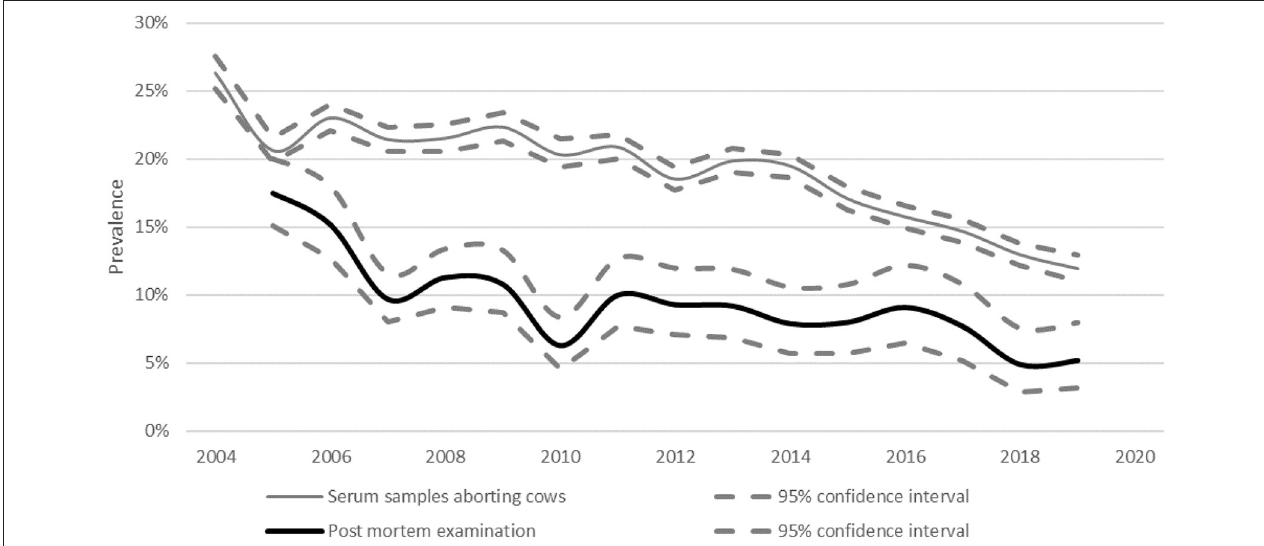
FIGURE 11 | Percentage of abortions in which Neospora was diagnosed as the cause since 2004.